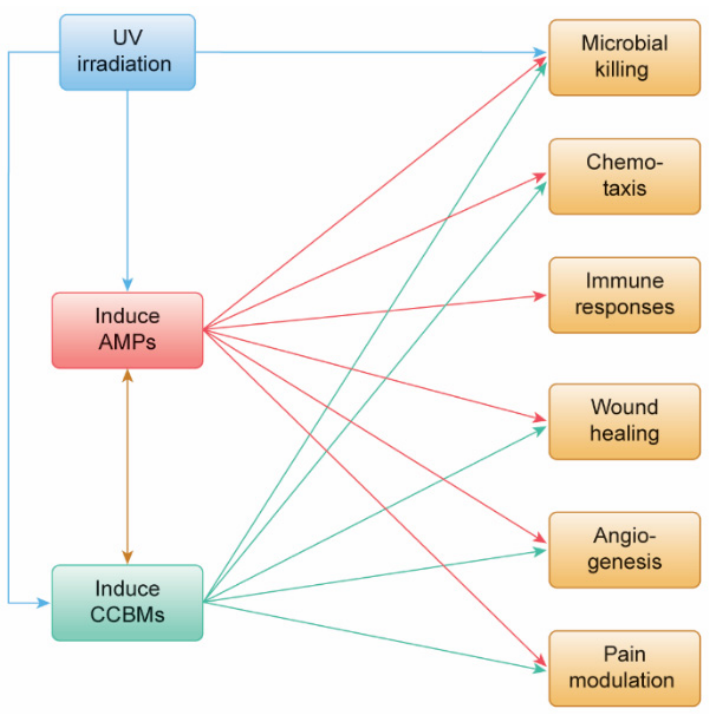
Figure 1. A schematic diagram of the proposed effects of UV irradiation on endodontic infection and inflammation, pain, and tissue healing. UV irradiation can kill microorganisms directly (blue line). UV irradiation can also induce host cells to express antimicrobial peptides (AMPs) and chemokines, cytokines, and biomarkers (CCBMs) (blue lines). AMPs can kill microorganisms (red line); induce the production of CCBMs (brown line); and induce chemotaxis, modulate immune responses, assist in wound healing, play a role in angiogenesis, and reduce pain (red lines). CCBMs can kill microorganisms (green line); induce the production of AMPs (brown line); and induce chemotaxis, modulate immune responses, assist in wound healing, play a role in angiogenesis, and reduce pain (green lines).